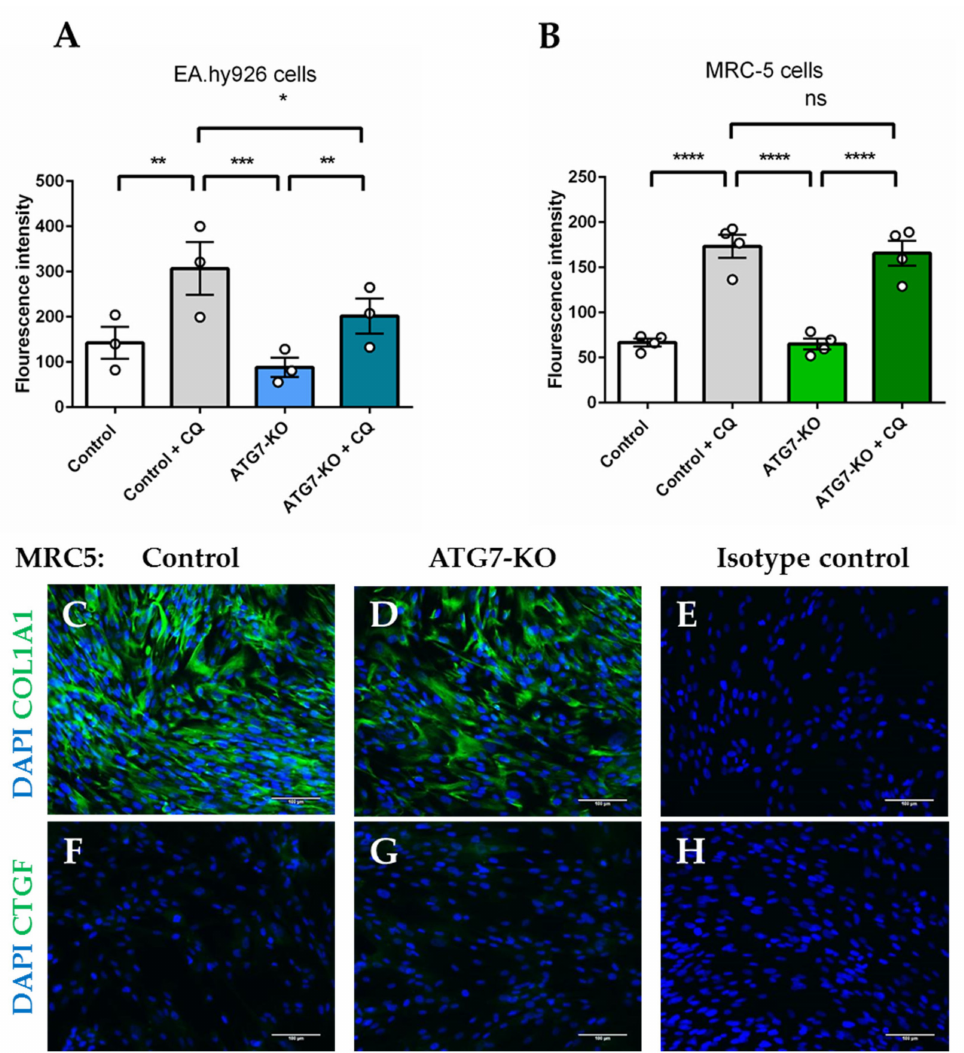
Figure 2. Autophagosomal inhibition of the ATG7-knockout (ATG7-KO) in endothelial cells and fibroblasts. ( A ) Autophagy flux Fluorescence-activated cell sorting (FACS) measurements of control and ATG7-KO-EA.hy926 endothelial cells ( B ) Autophagy flux Fluorescence-activated cell sorting (FACS) measurements of control and ATG7-KO-MRC-5 fibroblasts cells ( C – E ) COL1A1 immunofluorescence of control and ATG7-KO-MRC-5 cells (F-H) CTGF immunofluorescence of control and ATG7-KO-MRC-5. Scale bar represents 100 µ m. * p < 0.05, ** p < 0.01, *** p < 0.001, **** p < 0.0001, 2-way